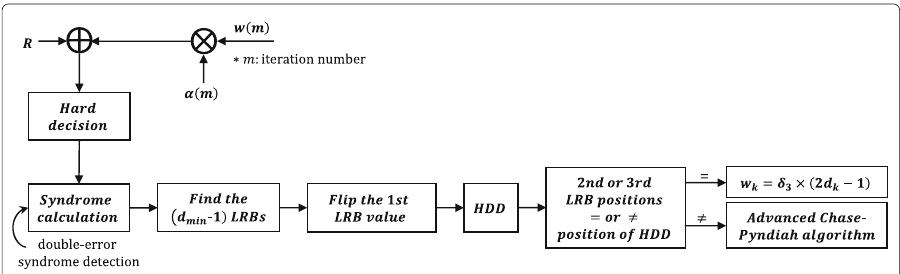
Fig. 3 A block diagram illustrating the detailed procedure of the proposed HISO decoding algorithm when detecting the double-error